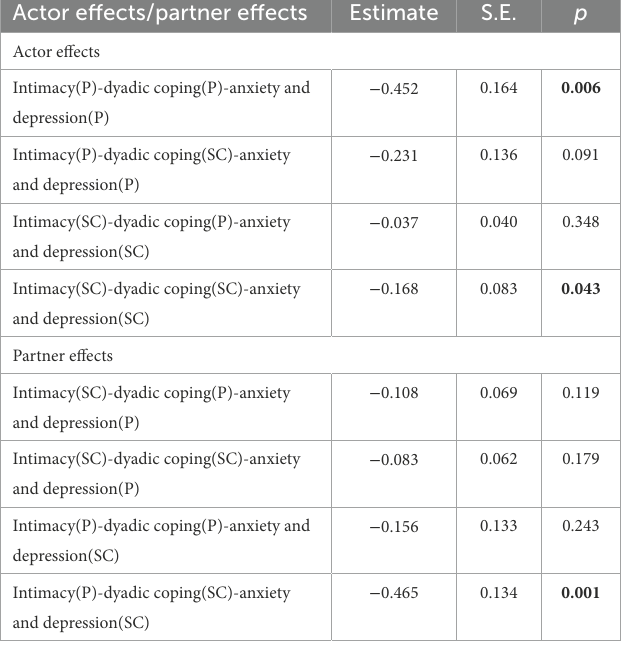
TABLE 5 The mediating effect of dyadic coping and anxiety and depression in intimacy of patients with pancreatic cancer and spousal